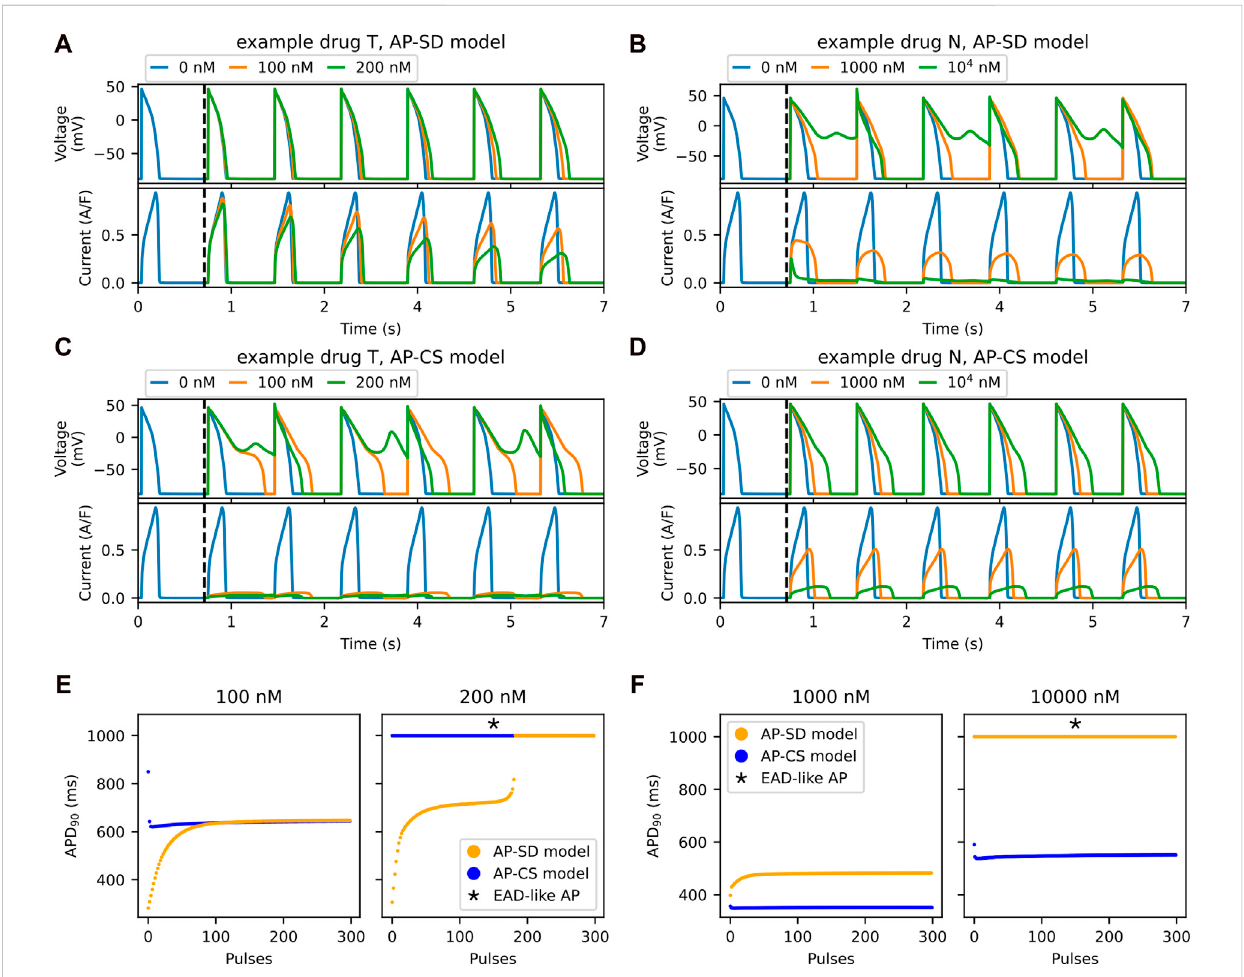
FIGURE 5 The accumulation of drug compounds at the channel due to being trapped is well-observed in the transient phase. Example drug T shows a longer transient phase than an example drug N in the SD model. The fi rst six pulses of AP (top row) and its hERG current (bottom row) for the AP-SD model after the addition of (A) an example drug T and (B) an example drug N. The vertical black dashed lines indicate the addition of drug into the system after 1,000 pulses of pacing. The fi rst six pulses of the AP (top row) and the hERG current (bottom row) for the AP-CS model after the addition of (C) example drug Tand (D) example drug N,of which its hERG ionic conductance is scaled to model the drug effect. (E) The APD 90 values ofboth theAP-SD modelandtheAP-CSmodelarecomparedat100and200 nMofexampledrugT. (F) TheAPD 90 valuesofboththemodelsarecomparedat1,000 nMand 10 4 nM of example drug